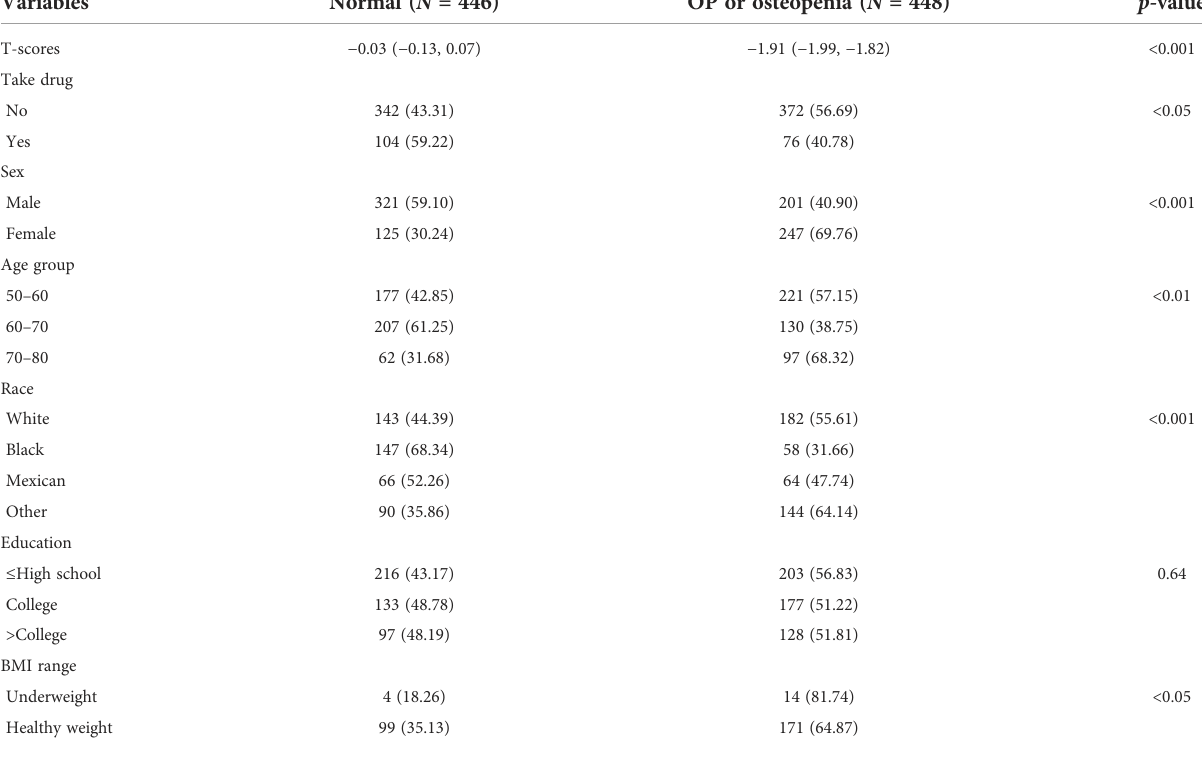
TABLE 1 General characteristics of participants a